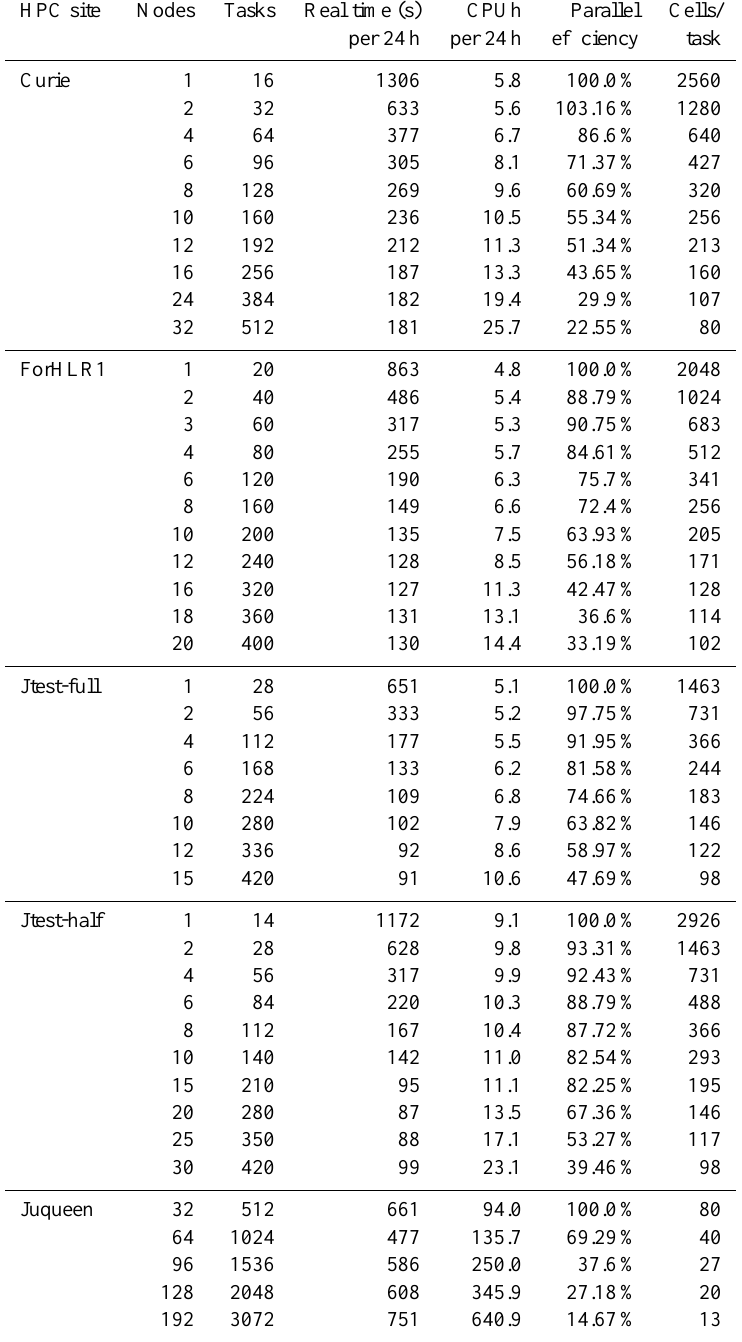
Table D1. Scaling tests for the 120km regular mesh on the four HPC